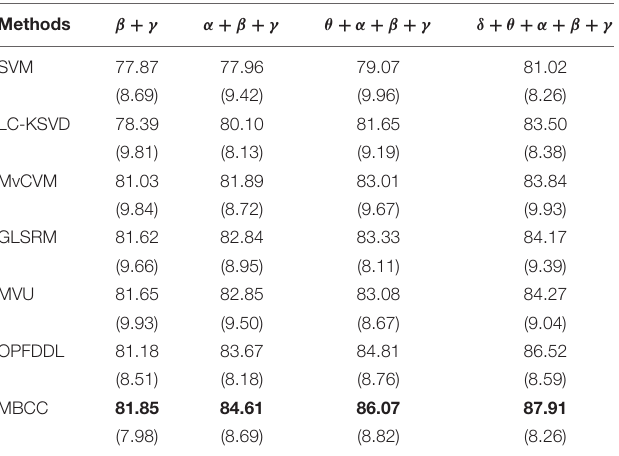
TABLE 4 | The accuracy (standard deviations) of all methods on SEED dataset in session 3.